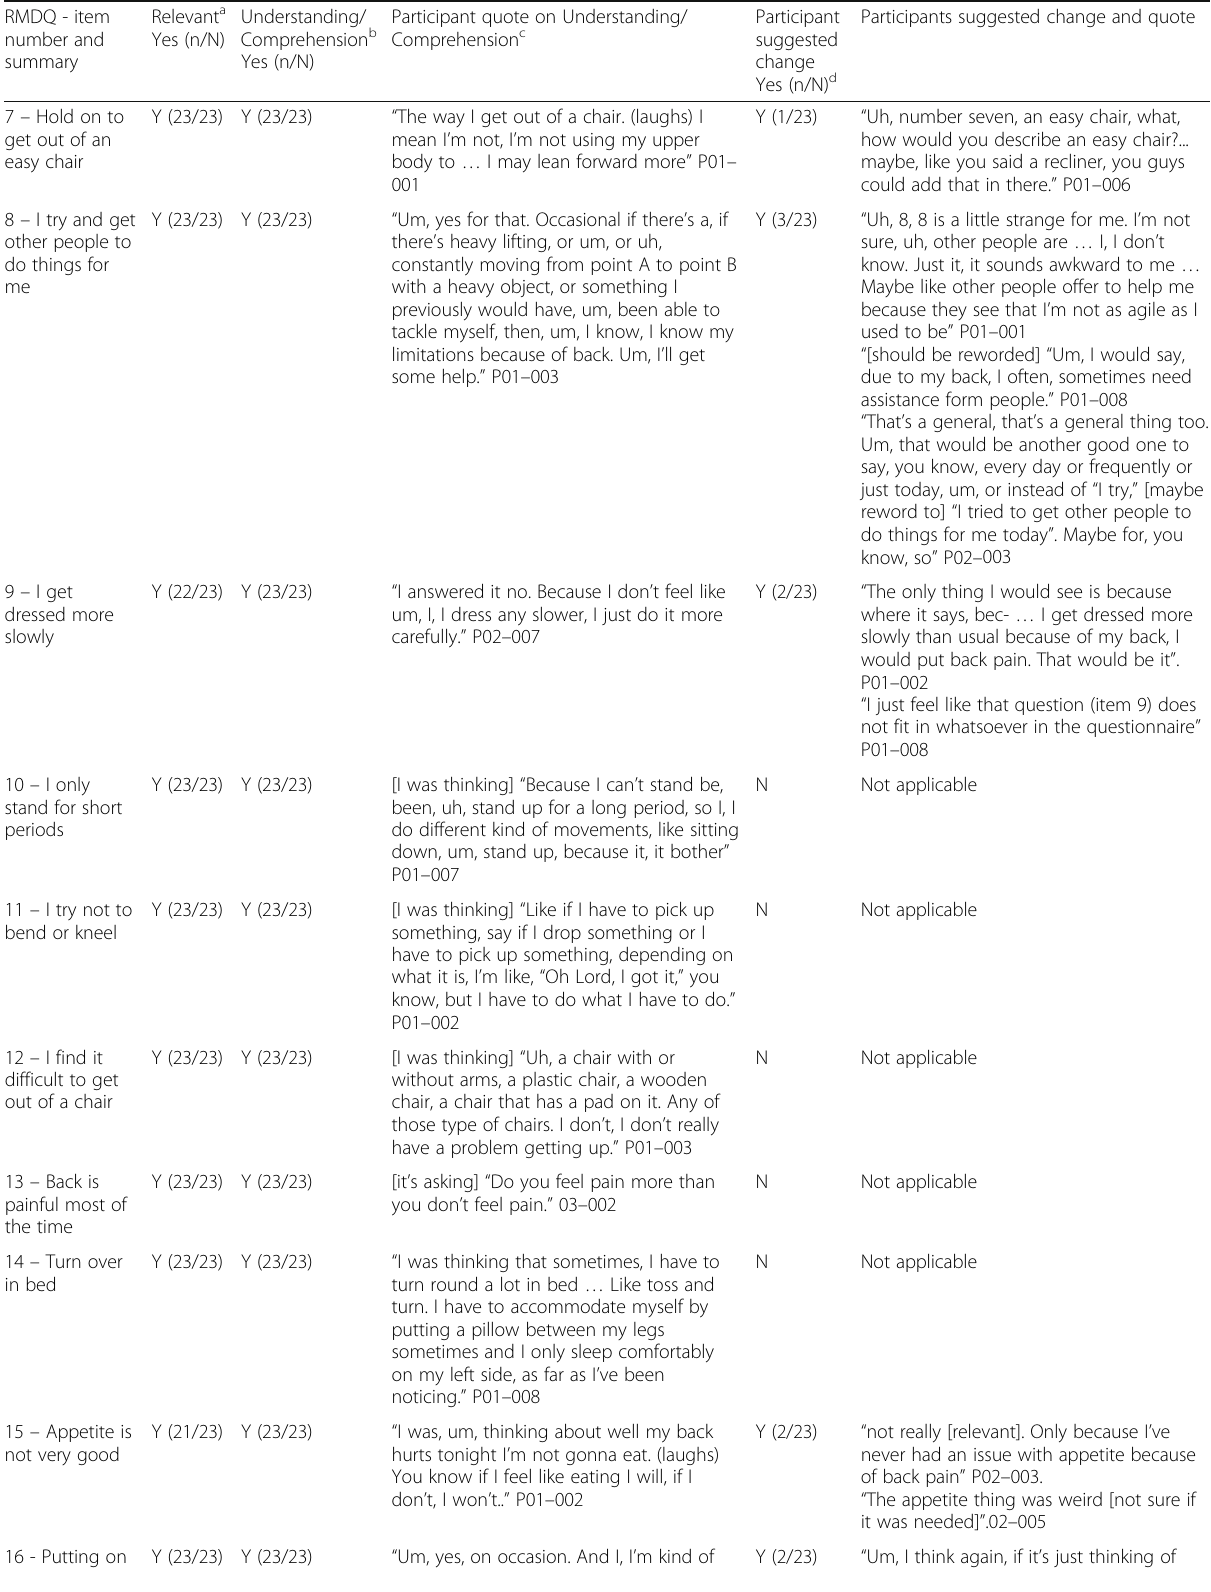
Table 4 Item relevance and participants ’ suggested edits